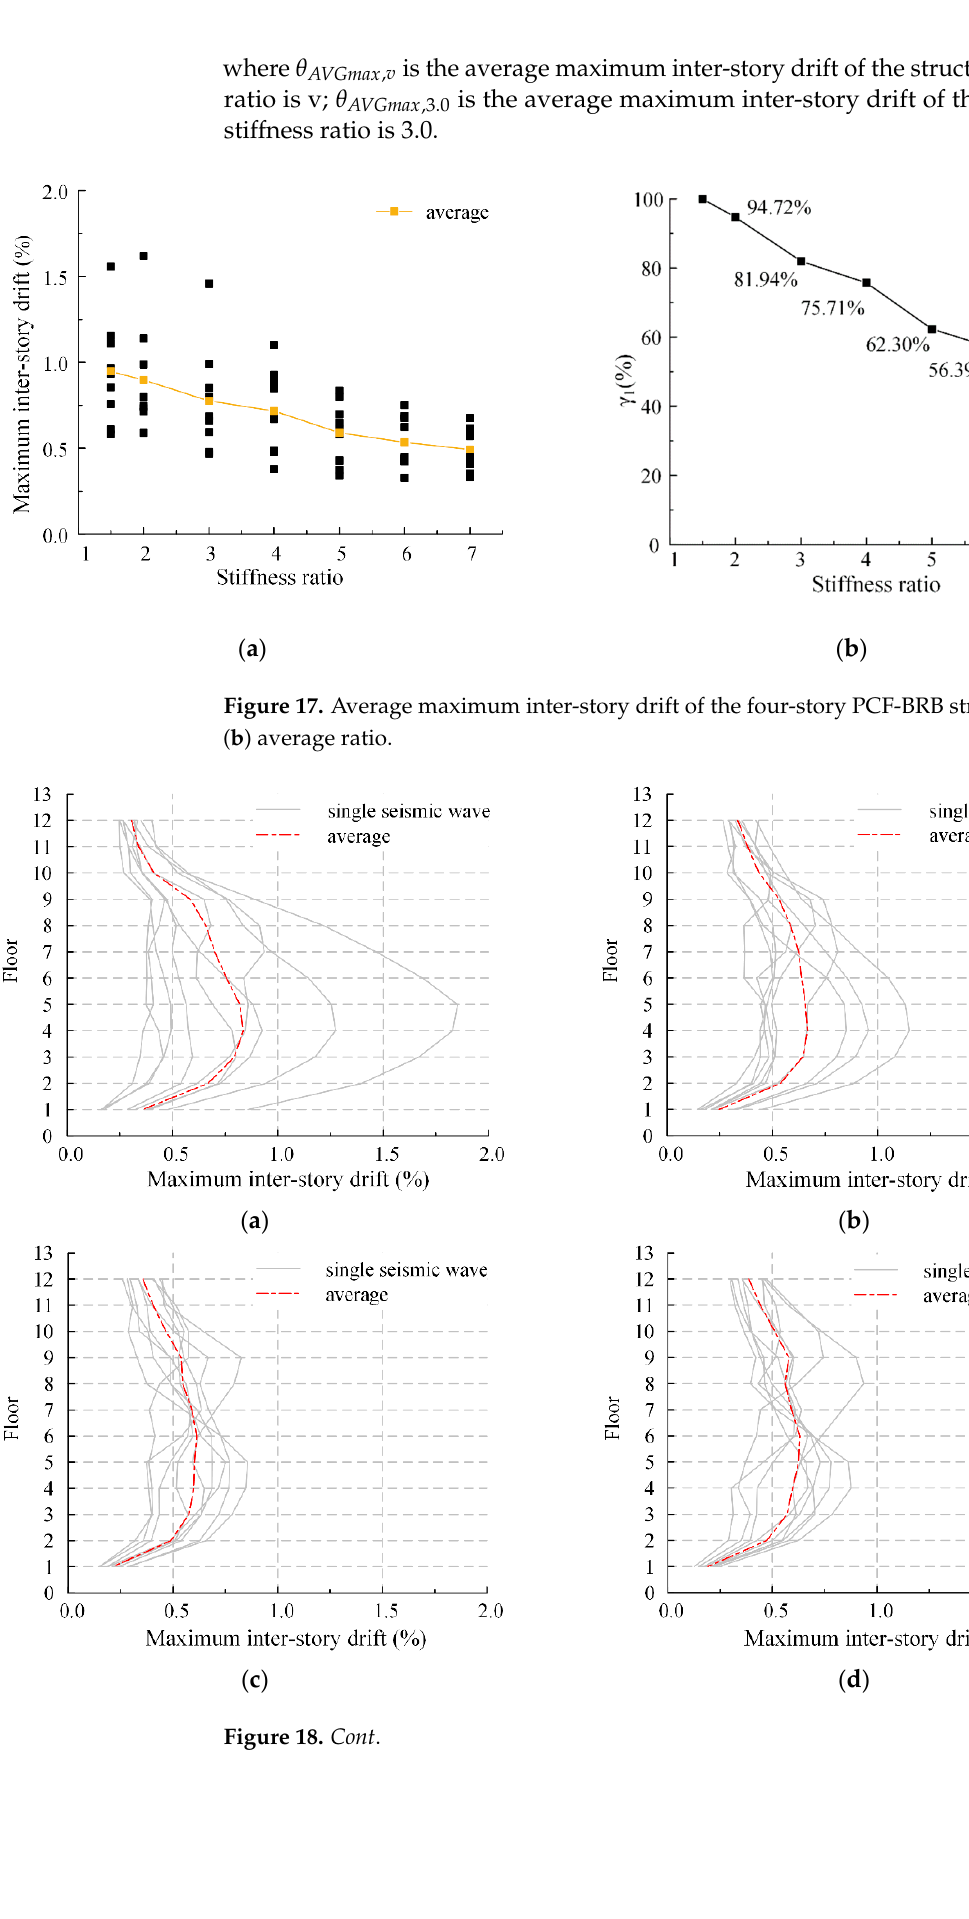
( e ) Figure 18. Maximum inter-story drift response of the 12-story PCF-BRB structure: ( a ) modal12-3.0; ( b ) modal12-4.0; ( c ) modal12-5.0; ( d ) modal12-6.0; and ( e ) modal12-7.0. Figure 19a shows that the average of the maximum inter-story drift changed with the stiffness ratio. The definition of γ 2 in Figure 19b is expressed as Equation (13), which shows the average variation of maximum inter-story drift. When the stiffness ratio was 5.0, the average maximum inter-story drift decreased to 80.12%, and when the stiffness